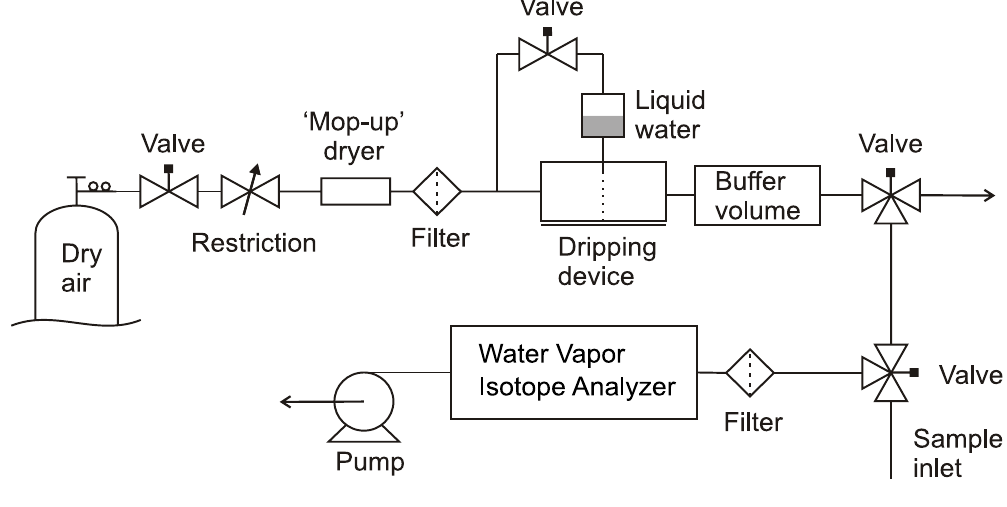
Fig. 1. Schematic diagram of the gas handling